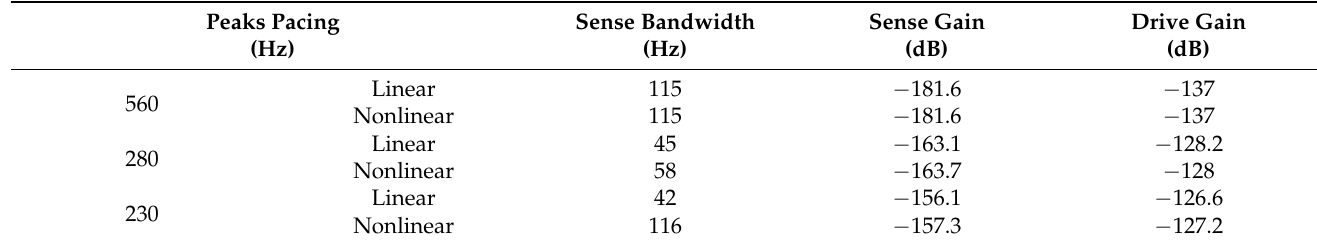
Table 2. Effect of peaks spacing on gain and bandwidth.